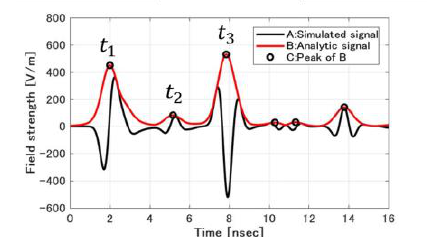
Figure 2. Reflected wave simulated by gprMax.